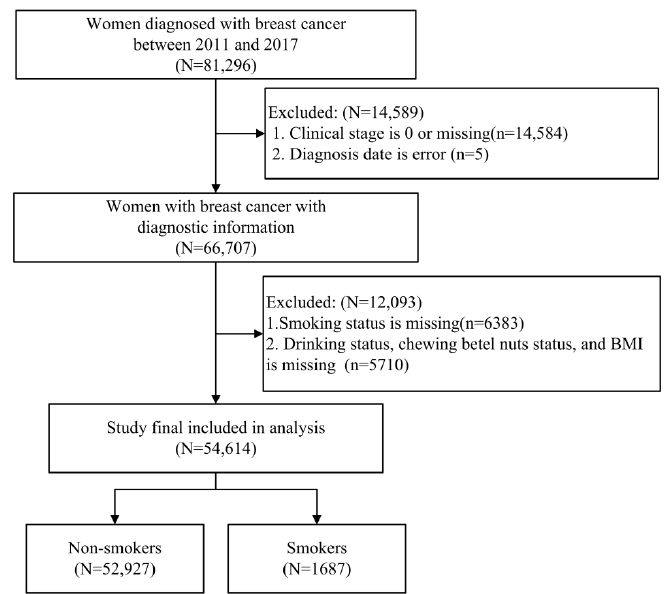
Figure 1. Study selection flowchart.